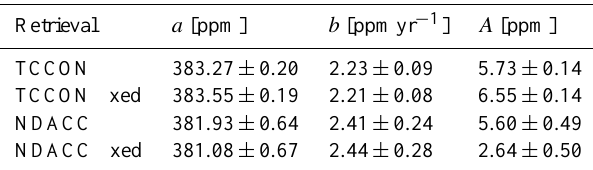
sented in Table 3. The comparison of the fitted amplitudes for the different retrievals allows for an estimate of the mag- nitude of the dampened seasonal cycle